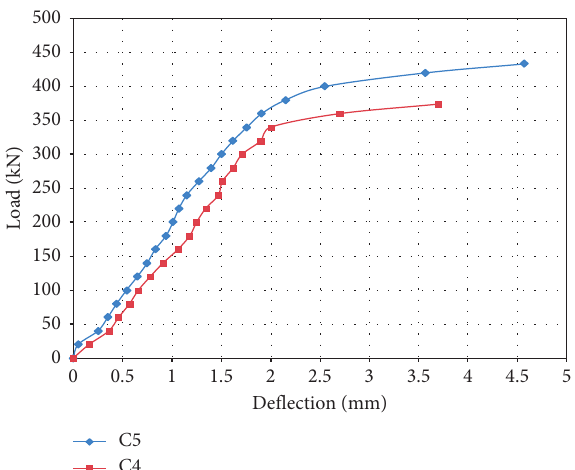
Figure 9: Load-deflection curve of corbels with 50% weight fractions of replacement aggregate for concrete strength 35.1 and 45.8MPa and a/d ratio 0.5.